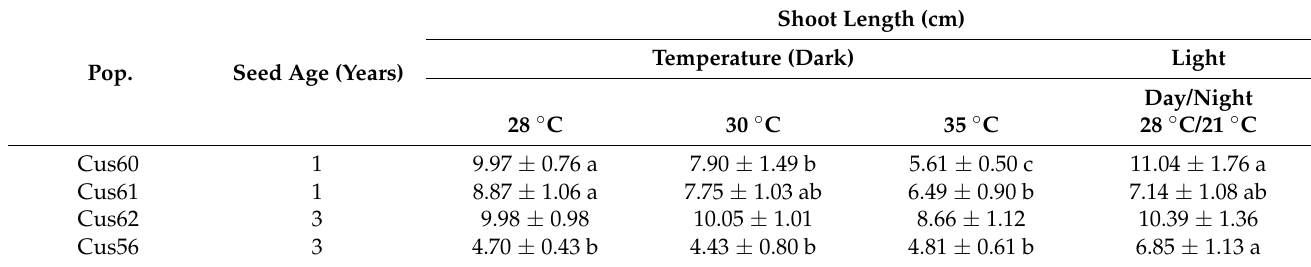
Table 5. Shoot length of 26 populations of C. campestris at 28, 30, and 35 ◦ C temperatures (dark) and under light treatment (28 ◦ C/21 ◦